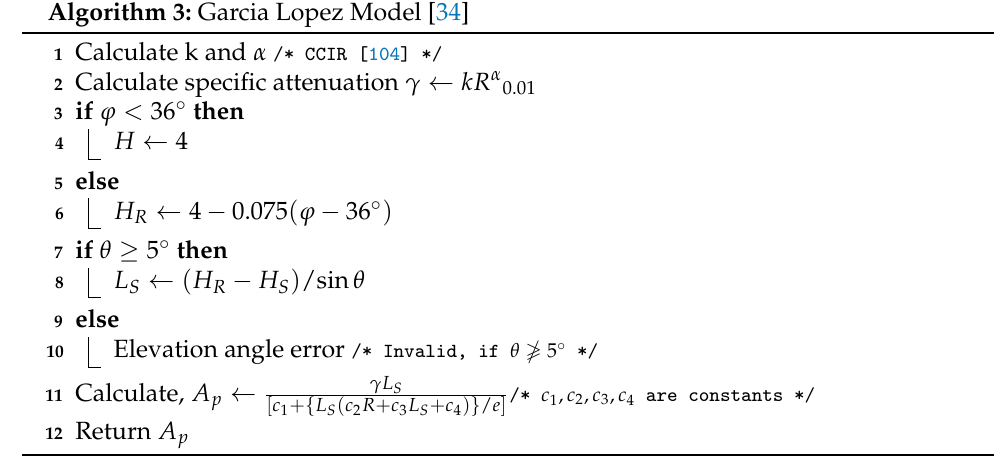
Algorithm 3: Garcia Lopez Model